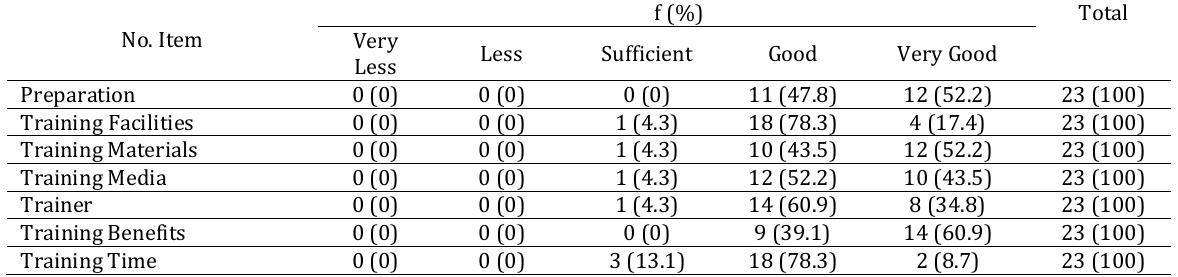
Table 7. Caregiver Response to the Training on Caring for a Physically Disabled Child March-April 2017 (n= 23) No. Item